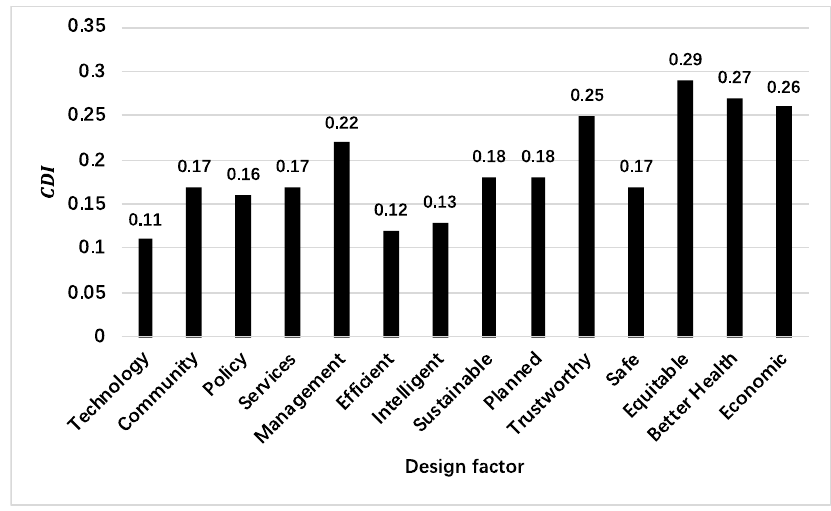
Figure 3. CDI of each factor ( the maximum value of consensus dispersion was set to 0.3 ). According to the results of the first round of the survey, the CDI of all the survey items was less than 0.3, which shows that the survey results achieved a consensus. Ac ‐ cording to Table 5, technology, service, and policy received higher average scores and